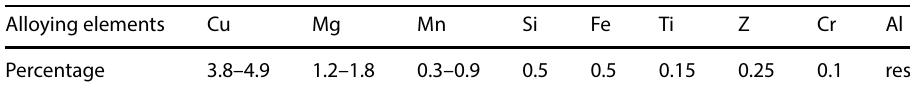
Table 1 Chemical composition of AA2024 in wt% [30]